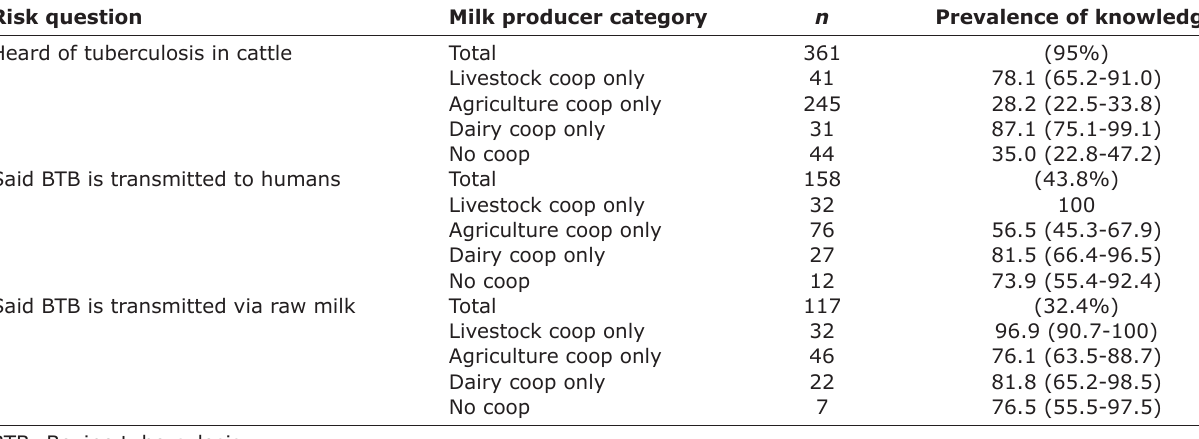
Table-1: Responses about bovine tuberculosis. Risk